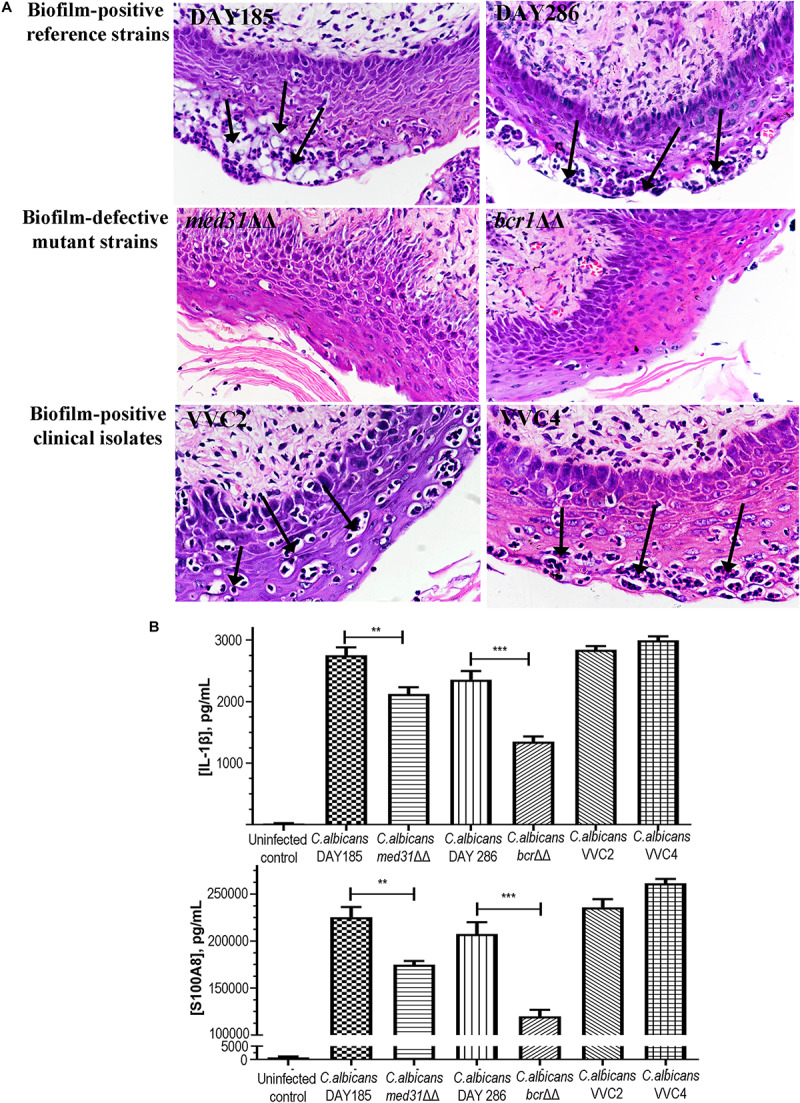
Histopathological and inflammatory changes of the vaginal epithelium after exposure to C. albicans of different biofilm phenotypes. (A) Vaginal histopathological examination (H&E staining, 400×) showed the formation of numerous microabscesses and neutrophil infiltration (black arrows) in the cornified epithelium after mice were infected with biofilm-positive C. albicans reference strains (DAY185 and DAY286) and clinical isolates (VVC2 and VVC4). Minimal neutrophil infiltration and microabscesses were seen when biofilm-defective mutant strains (med31ΔΔ and bcr1ΔΔ) were used to infect the mice. The experiments were repeated on three different occasions. (B) Local inflammatory responses to C. albicans infections in the mouse vagina. C. albicans DAY185 and its med31ΔΔ mutant strain, C. albicans DAY286 and its bcr1ΔΔ mutant strain, and two clinical isolates from patients with vaginal candidiasis were tested respectively. Cytoplasmic protein S100A8 and cytokine IL-1β were selected as the representative inflammatory effectors. The experiments were repeated three times in duplicate. Means and standard errors were shown. One-way ANOVA or a non-parametric test was used for two-set comparisons. **p < 0.01, ***p < 0.001.